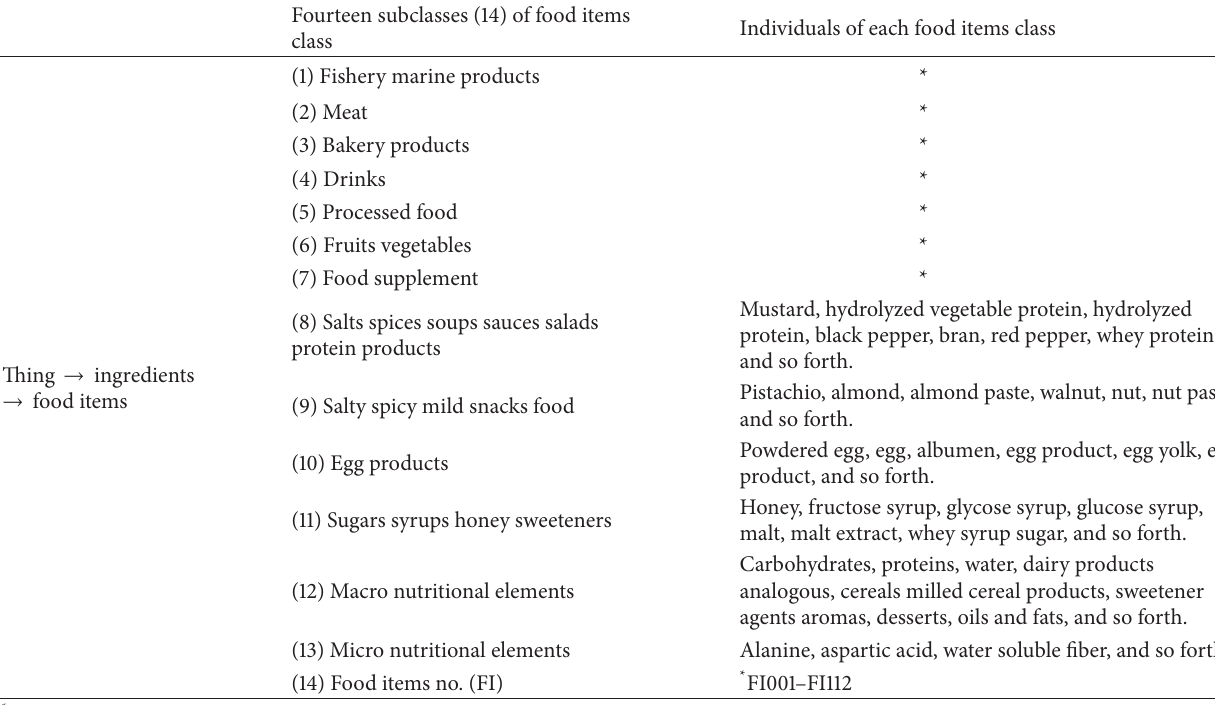
Table 6: The subclasses and individual entries of food items class. Fourteen subclasses (14) of food items